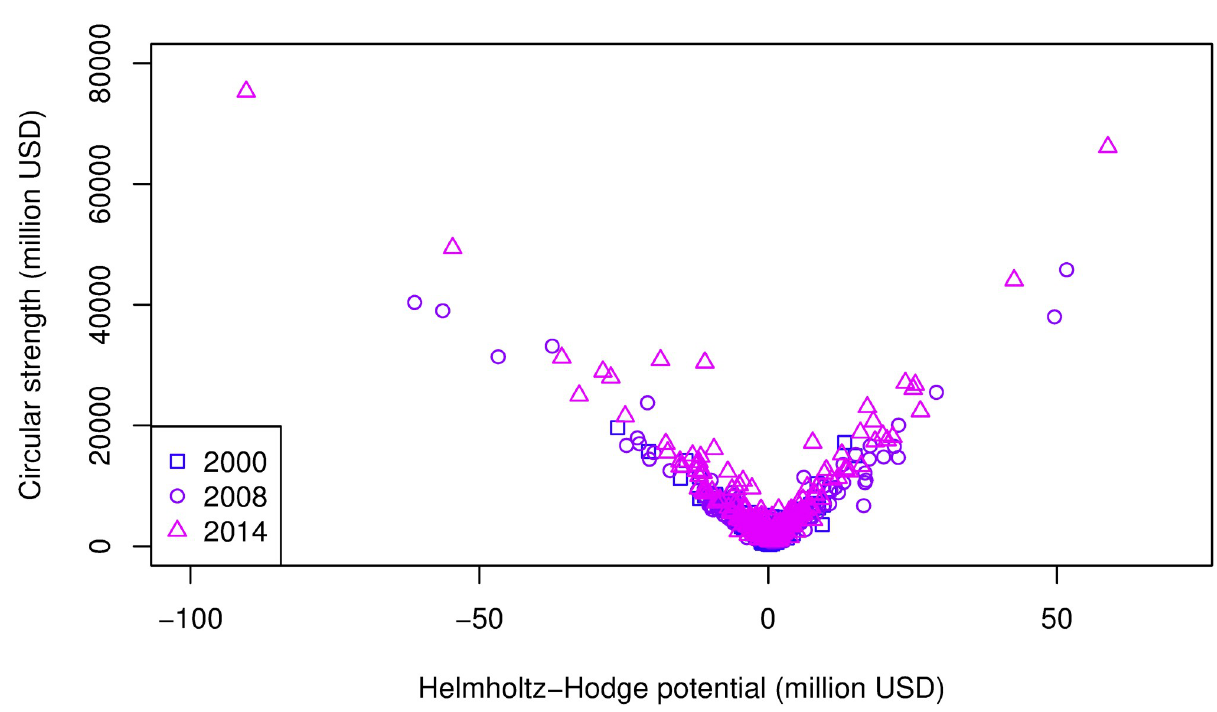
Fig 7. Scatter plot of correlation between circular strength and Helmholtz-Hodge potential in the Pacific Rim community in 2000, 2008, and 2014. The years show the similar inclinations of the V shape.